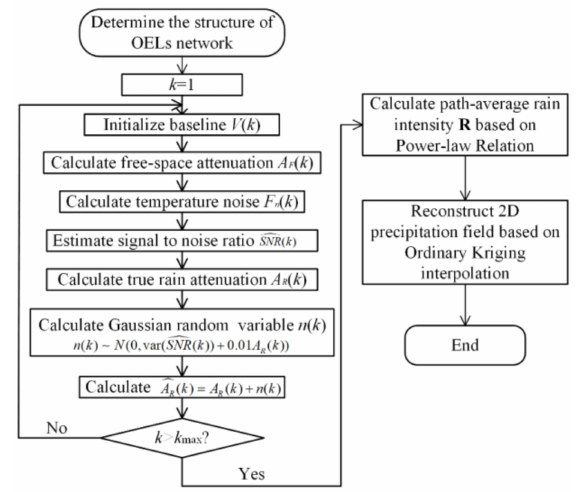
Figure 3. The simulation process of rainfall field